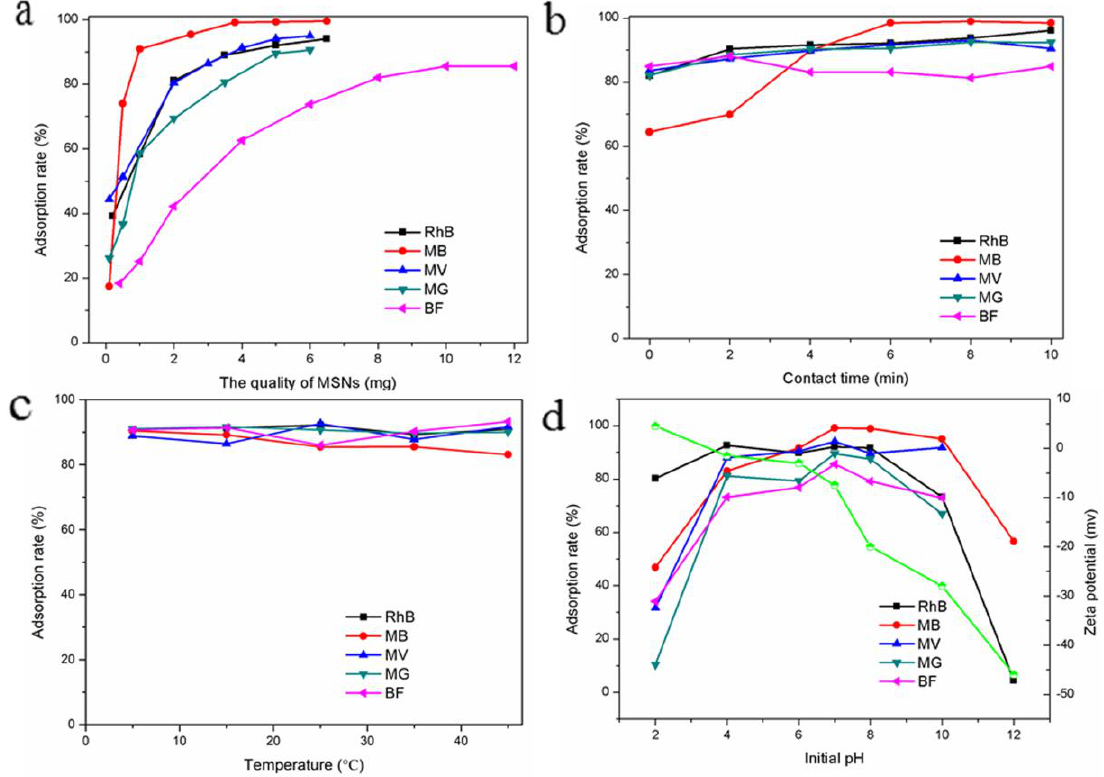
Figure 3. The effect of the mass of the adsorbent ( a ), the contact time ( b ), the temperature ( c ) and the initial pH ( d ) on the adsorption efficiency.